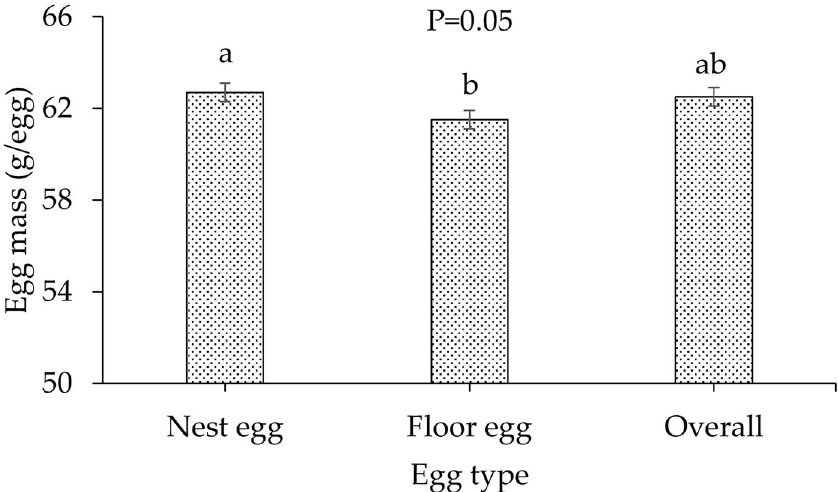
Fig 3. Illustration of egg mass of different egg types. Data were from 40–43 weeks of bird ages in flock 2. Values having different letters atop the bars are significantly different (n = 24), with significance level of 0.05, least square difference post-hoc analysis, and PROC MIXED statement.